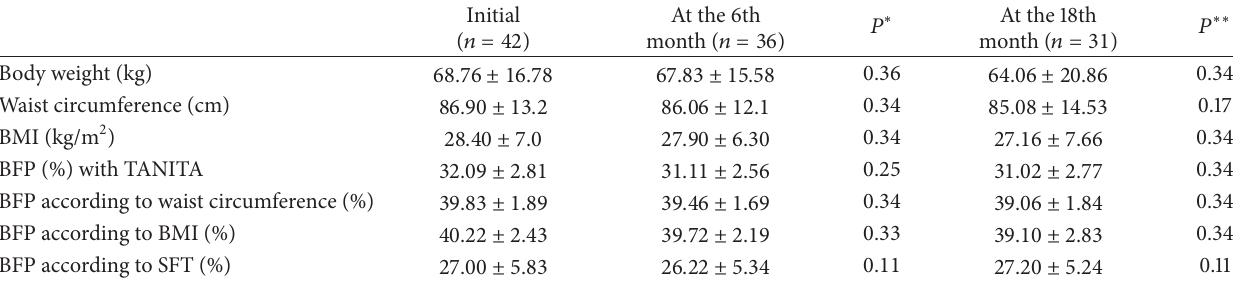
Table 1: The characteristics of patients during follow-up.